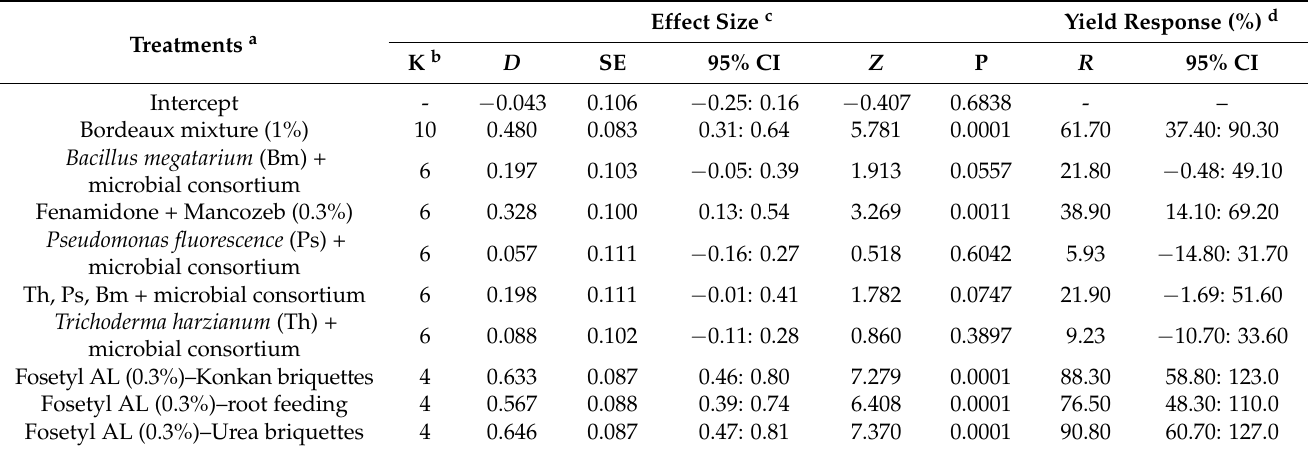
The network meta-analysis model fitted the data collected from the field trials carried out under multi-location conditions in India. a Active ingredients of the evaluated treatments for FRD in arecanut. b The number of trials selected for each specific treatment with untreated controls. c Mean yield differences ( D , kg/palm) for each treatment corresponding to untreated checks; standard error (SE) of D and 95% confidence interval (CI) around D ; Z (standard normal) statistic from the network meta-analytical model; p = probability value (level of significance). d Average yield response ( R ) computed by back-transformation of estimated FRD incidence and 95% CI (lower and upper limits) containing R ; Test for Residual Heterogeneity; QE (df = 52) = 63.7404, p -value = 0.1274; Test